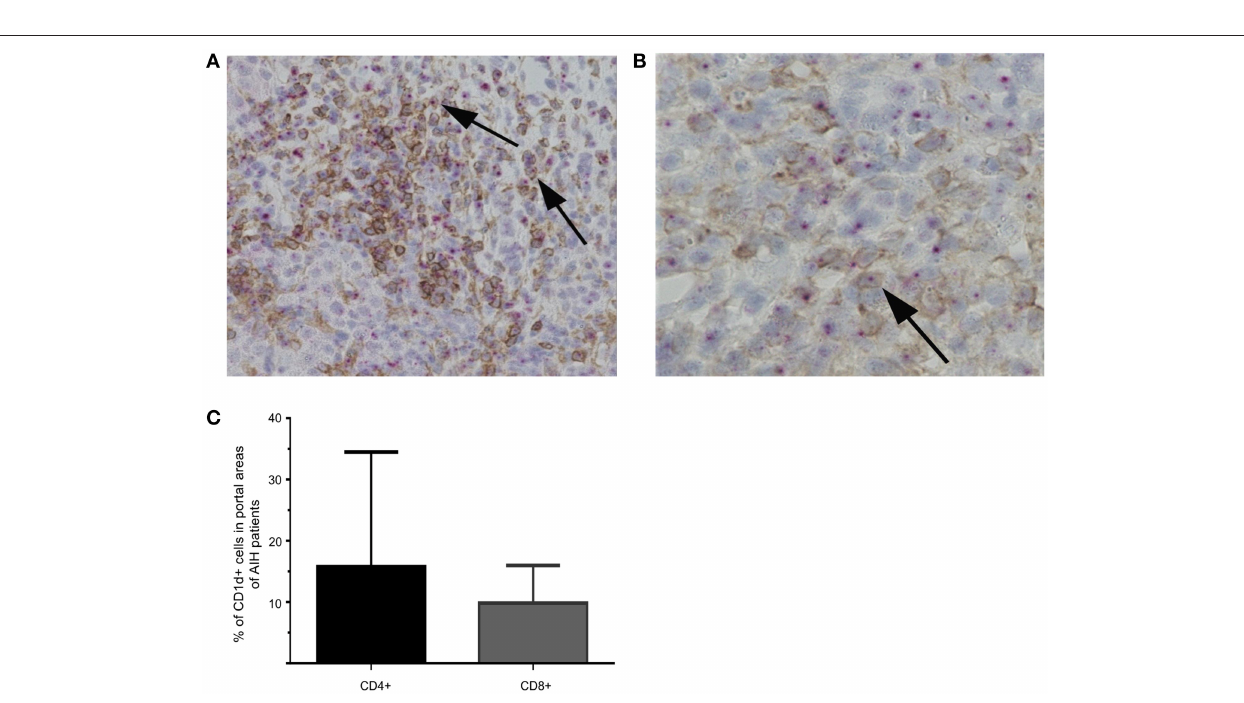
FIGURE 10 | Co-stainings of CD1d-RNA with CD4 or CD8 in liver biopsies. Representative co-stainings of CD1d-RNA (purple dots) with CD4 (brown) in 20x (A) or 40x (B) magnification are shown. Double positive cells are marked by arrows. Percentage of CD4 + CD1d (left bar) or CD8 + CD1d (right bar) double positive cells in portal areas of AIH patients are displayed (C)